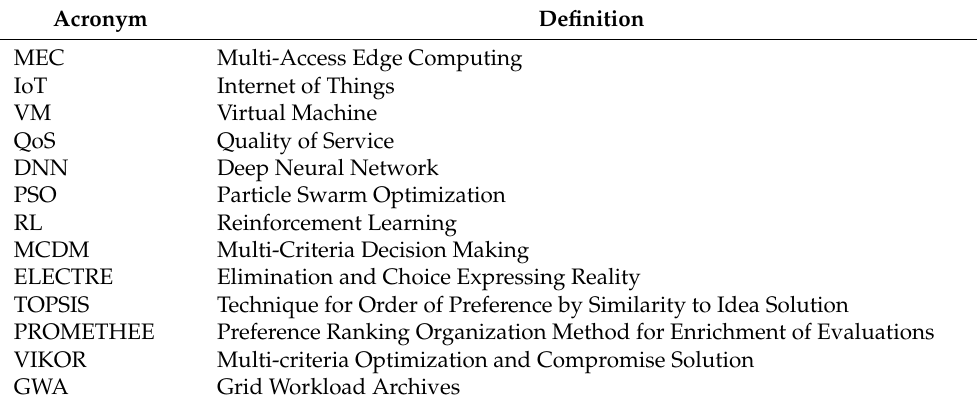
Table 3 list the acronyms used frequently throughout this paper. Table 3. List of acronyms frequently used in this